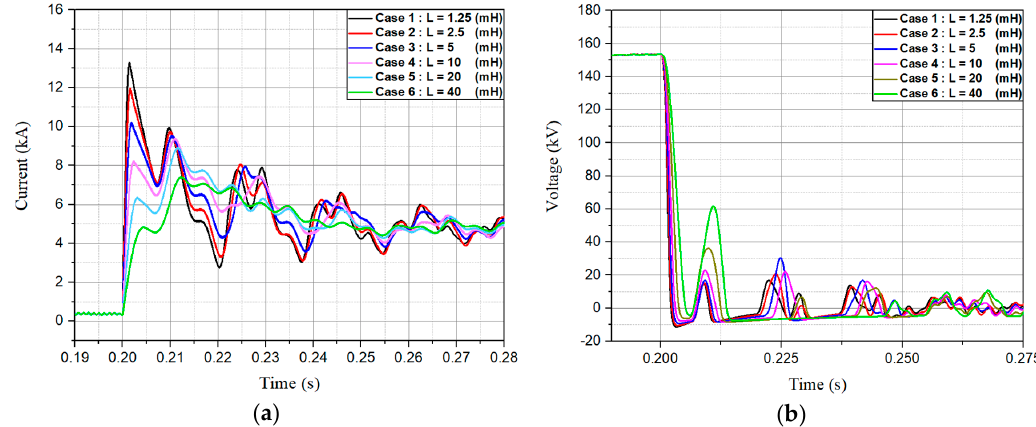
Figure 10. The DC current and voltage waveform in transient state without SFCL: ( a ) current waveform; ( b ) voltage waveform measured at converter terminals.